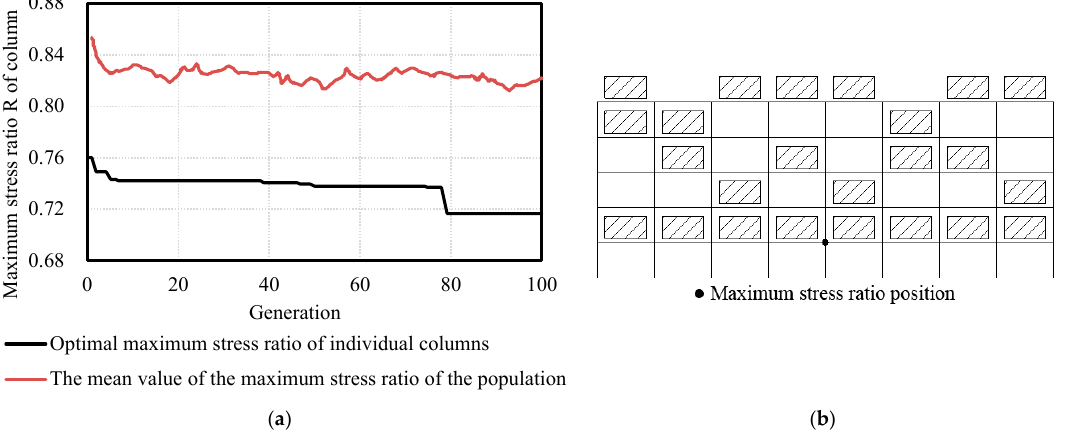
Figure 16. The most favorable distribution of load under 70% full load. ( a ) Tracking chart of optimization performance of GA. ( b ) The most favorable distribution of load (H = 2.68, P = 0.07).